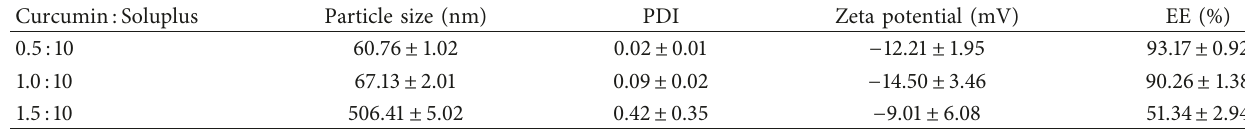
Table 1: Effect of dosage on the size and zeta potential of Cur-TPGS-PMs (mean